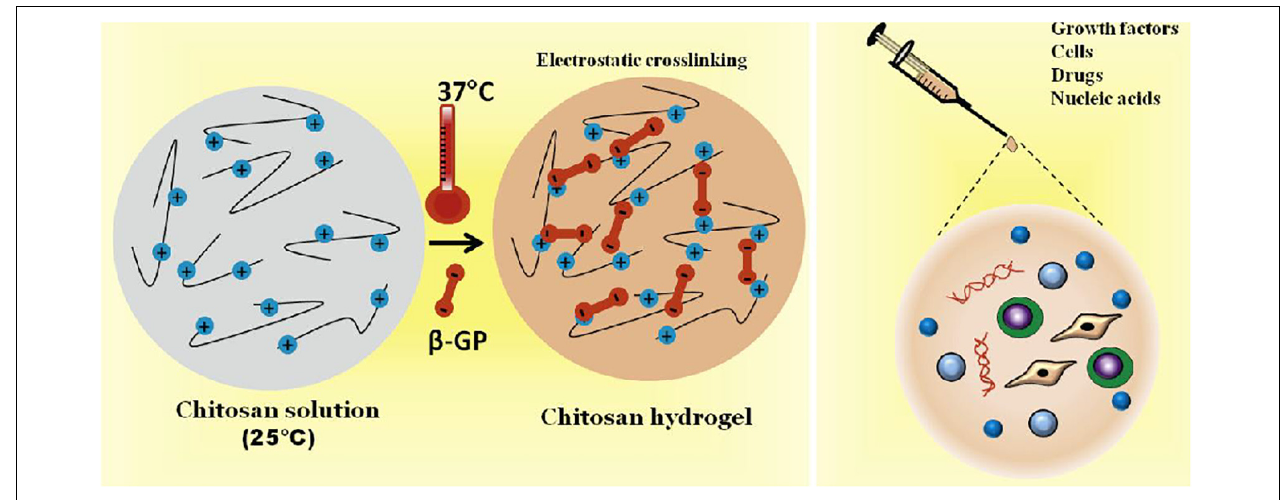
FIGURE 4 | Schematic representation of thermal-responsive CS/ β -GP hydrogels encapsulating with various growth factors, cells, drugs and nucleic acids for bone tissue engineering. Reproduced from Saravanan et al. (2019) with permission from Copyright 2019